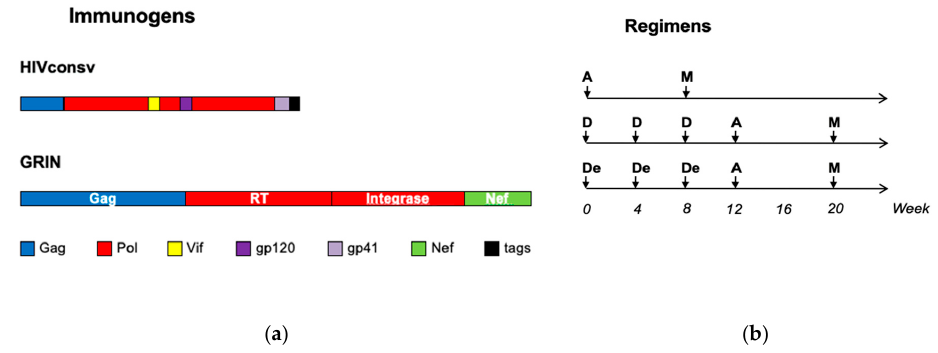
Figure 1. The HIV-CORE 004 trial: Vaccine immunogens and regimens. ( a ) Schematic representation of the HIVconsv immunogen derived from 14 conserved regions of the human immunodeficiency virus type 1 (HIV-1) proteome. For each segment, the clade of consensus aa sequence is shown above and the HIV-1 proteins from which it was derived are color-coded. C-terminal CD8 + T-cell and